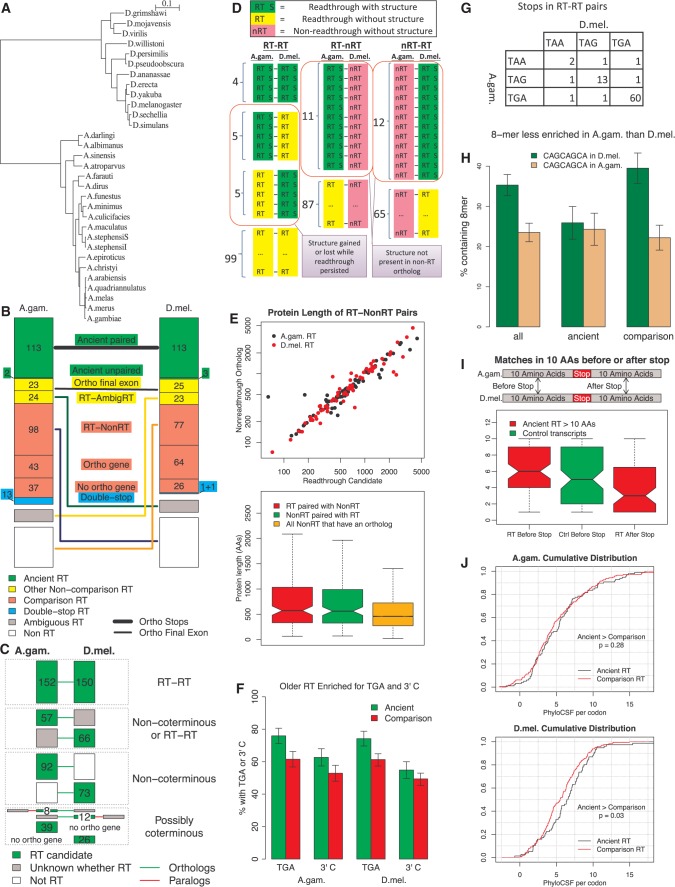
Mosquito-fly comparison provides insights into readthrough evolutionary dynamics. (A) Phylogenetic tree of 12 Drosophila and 19 Anopheles species. (B) Boxes quantify stop codons in each category used in our cross-clade comparisons. (C) Boxes classify and quantify the common and distinct portions of the readthrough gene repertoires of A. gambiae and D. melanogaster, to determine which differences are associated with gene birth and death (“coterminous”). Bottom group shows differences that might be due to coterminous events, whereas next higher group shows differences that cannot be. In other cases we do not know if the repertoires are different but if they are it is not due to coterminous events. At most 34% of the differences are due to coterminous events. (D) Among readthrough-readthrough pairs, nine have predicted RNA structures in A. gambiae and nine do in D. melanogaster, but only four have structures in both, implying that some structures are ancient whereas others have been gained or lost while readthrough persisted. None of the non-readthrough transcripts orthologous to readthrough candidates have structures, suggesting that the structures were not present for very long before readthrough appeared. (E) Upper figure shows first ORF length of each readthrough candidate orthologous to a non-readthrough transcript versus the first ORF length of the ortholog. Lower figure shows first ORF lengths of readthrough candidates orthologous to non-readthrough transcripts, corresponding lengths of the paired non-readthrough transcripts, and lengths of all non-readthrough transcripts in genes that have orthologs in the other species. There is almost no difference between the first ORF lengths of the readthrough candidates and their non-readthrough orthologs, but they are generally larger than the other non-readthrough transcripts, implying that longer genes are more likely to become readthrough rather than that genes tend to get longer after becoming readthrough. (F) The first stop codon is TGA and 3′ base is C in a larger fraction of ancient readthrough candidates than readthrough candidates in our comparison group. Error bars show standard error of mean. (G) Stop codon usage in ancient readthrough pairs. The dearth of pairs having a TGA stop codon in one species and not the other (only 4) implies that the increased prevalence of TGA among ancient readthrough candidates is due to loss of readthrough among TAA and TAG stop codons, rather than conversion of TAA or TAG to TGA. (H) Fraction of readthrough candidates containing most-enriched 8-mer. Error bars show standard error of mean. The 8-mer is highly enriched among readthrough candidates in each species, but significantly more so in D. melanogaster, with the difference concentrated among the readthrough candidates in the comparison group, implying the difference is due to an increased prevalence of the 8-mer in genes that have become readthrough in Drosophila since the lineages diverged. (I) The number of matches when aligning the ten amino acids after the first stop codon with the corresponding region of the orthologous transcript for readthrough-readthrough orthologous pairs is significantly fewer than the number of matches before the stop codon for these pairs or for orthologous pairs of control transcripts, implying that readthrough regions have been under less purifying selection at the amino acid level than other coding regions. (J) Ancient readthrough regions have higher PhyloCSF scores than ones in the comparison group, suggesting that older readthrough regions are under greater purifying selection at the amino acid level.